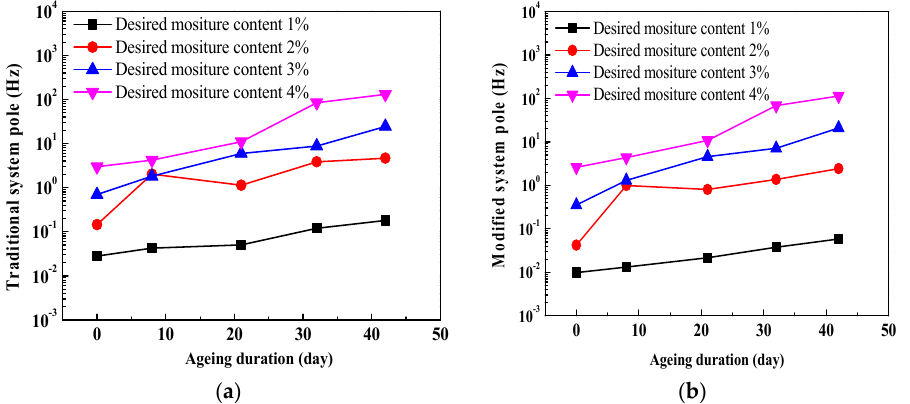
Figure 10. Comparisons of relationships between system poles and ageing duration. ( a ) Traditional system poles; ( b ) modified system poles.